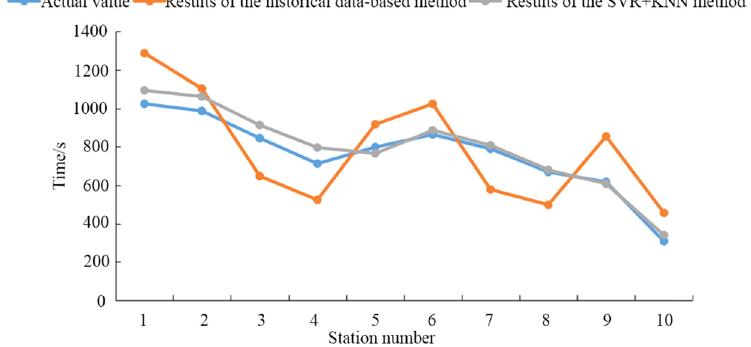
Figure 2: Comparison of prediction results.